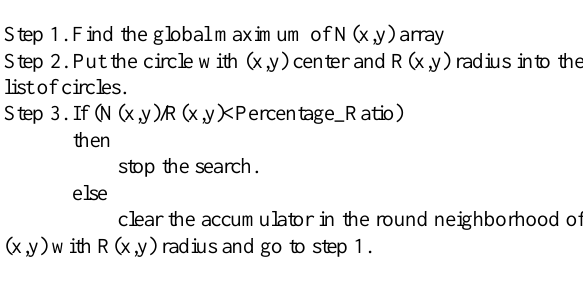
Figure 5. Gradients map